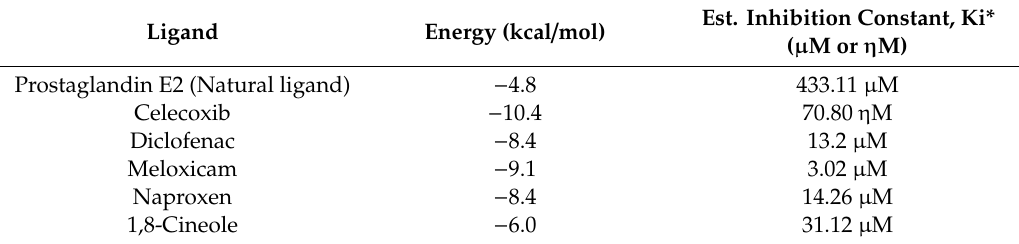
Table 2. Binding energy of the interaction the di ff erent ligands with prostaglandin G / H synthase 2 by the autodock procedure (cyclooxigenase